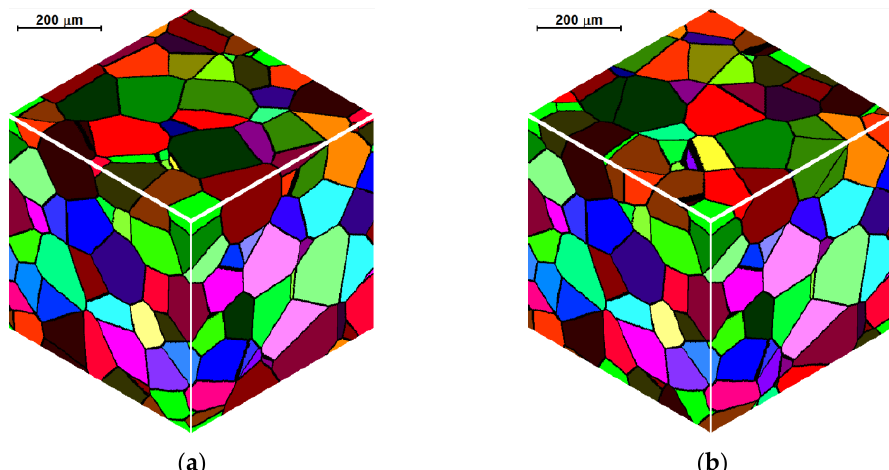
Figure 6. Boundary conditions with displacements in three-dimensional space: ( a ) one displacement, ( b ) two displace- ments along the one axis.